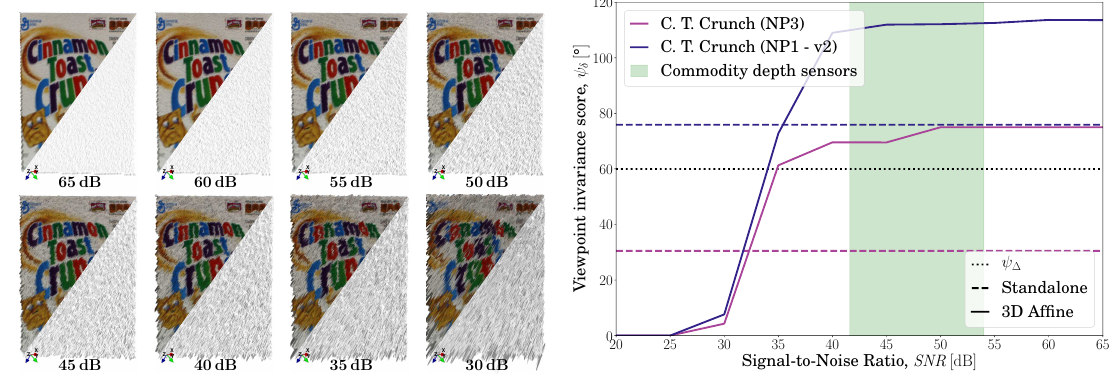
Figure 16. ( a ) a demonstration of different tested noise levels. The frame shows one of the 140 synthetic frames utilized, which simulated the ‘C. T. Crunch’ dataset with different viewpoints and cameras (the first two rows of Figure 8); ( b ) the proposed embedding achieved the targeted viewpoint invariance, ψ ∆ , for a wide range of depth noise, SNR 35dB, in both datasets, and it outperformed ≥ the standalone intensity-based approach in estimating viewpoint rotations despite the ideal intensity setting, in which no illumination or blur effects were